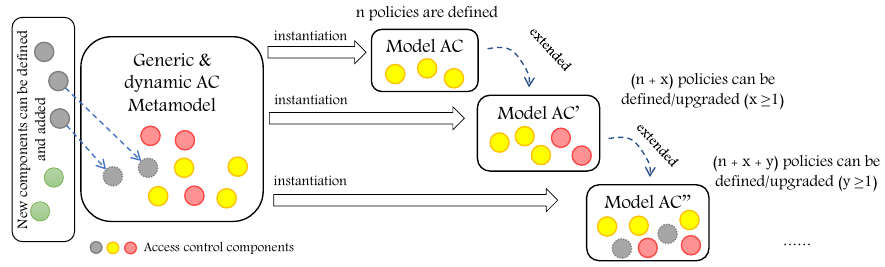
Figure 9. The concept of extensible AC